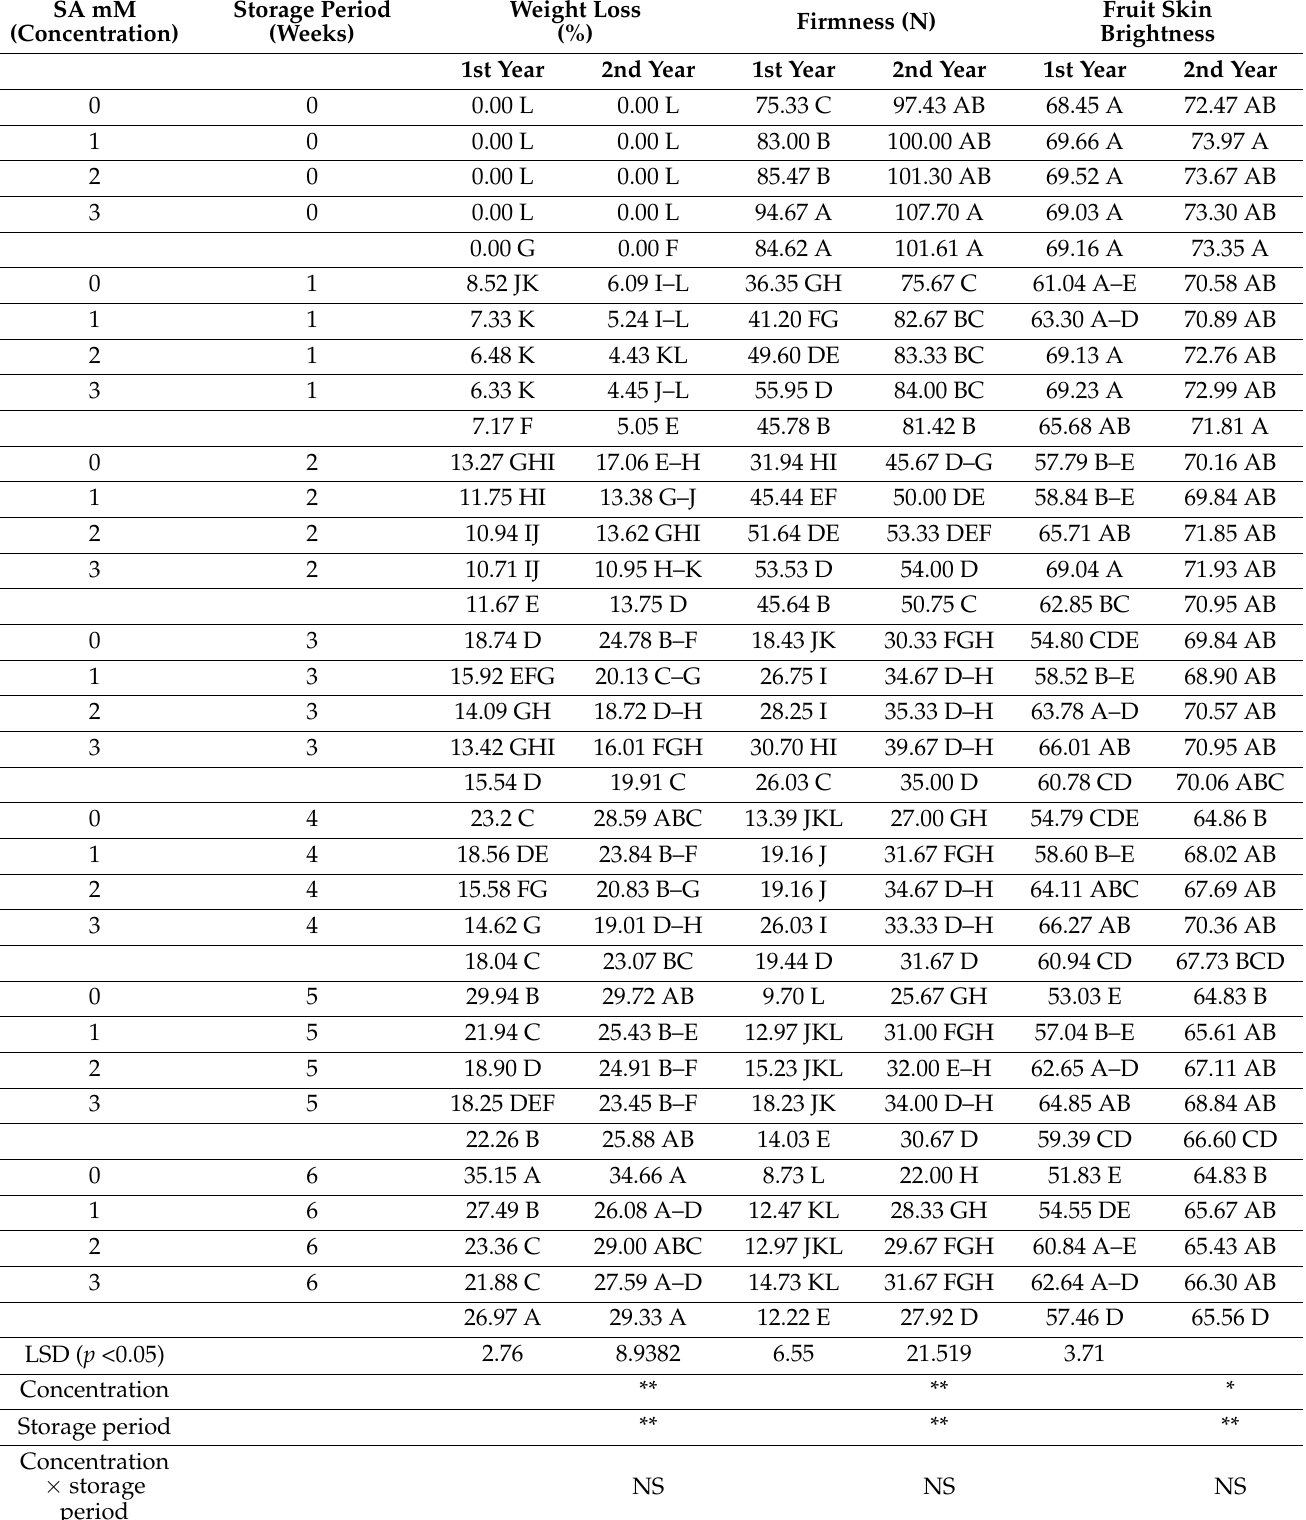
Table 3. Effect of different pre-harvest treatments of SA on the peach fruit physicochemical characteristics during low- temperature